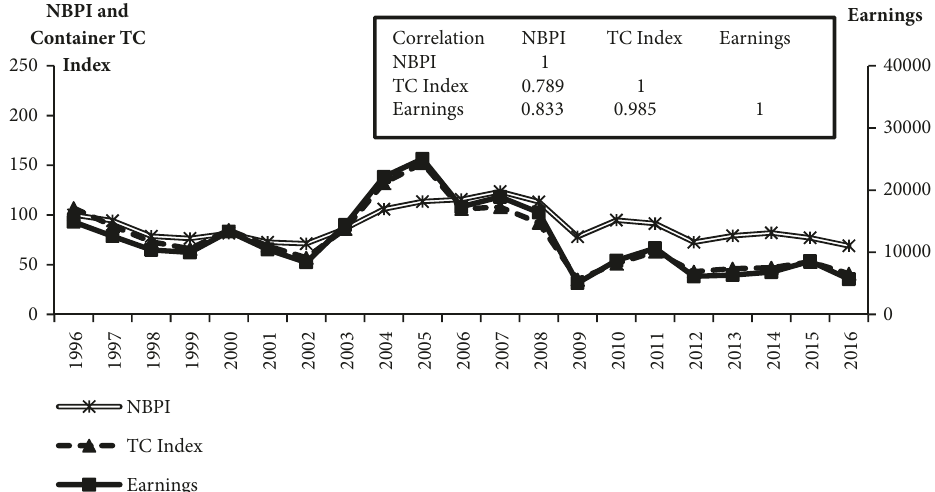
Figure 3: Correlations between new-building price, time charter index, and earnings in the container market.